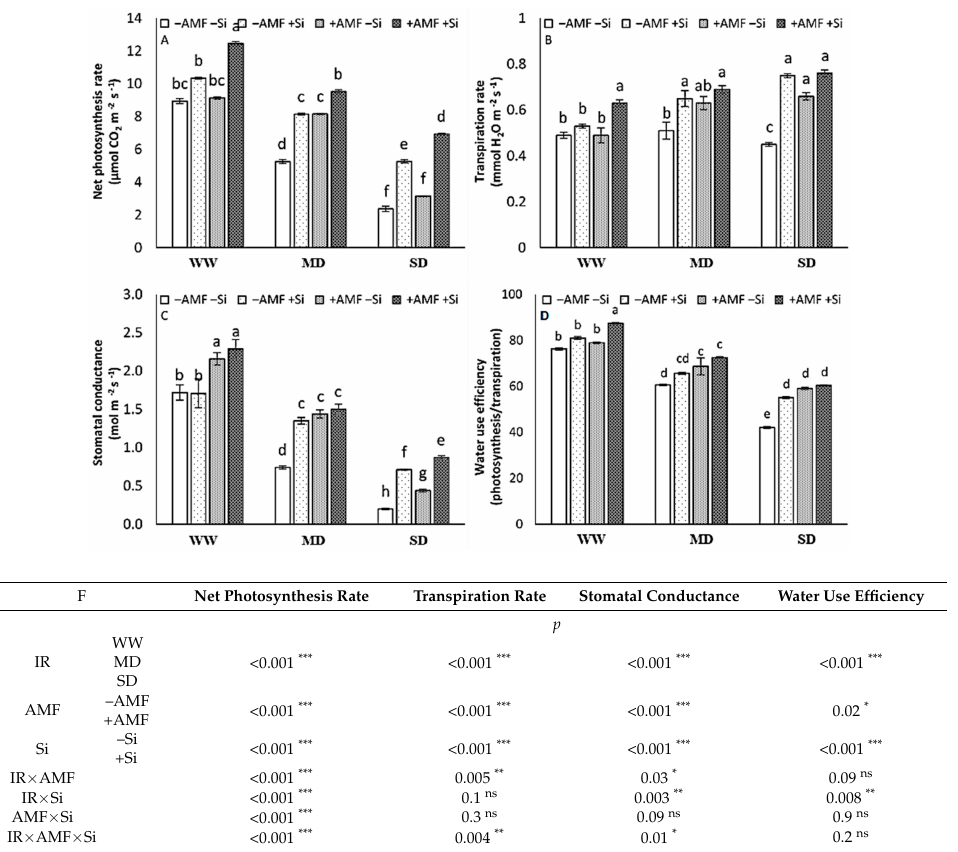
Figure 2. The net photosynthesis rate ( A ), transpiration rate ( B ), stomatal conductance ( C ), and water use efficiency ( D ) of strawberry plants at harvest after six experimental weeks under three irrigation regimes (IR): well-watered (WW), mild drought (MD), and severe drought (SD) without ( − AMF) or with inoculation with arbuscular mycorrhizal fungus (+AMF) Rhizophagus clarus (Walker & Schüßler), in the absence ( − Si) or presence of silicon (+Si, 3 mmol L − 1 Na 2 SiO 3 ). The bars show the treatment means (4 replicates) ± SE of the mean. The interactions among the main factors are in the table ( F ); *** p < 0.001, ** p < 0.01, * p < 0.05, and ns is not significant (Tukey test, alpha =